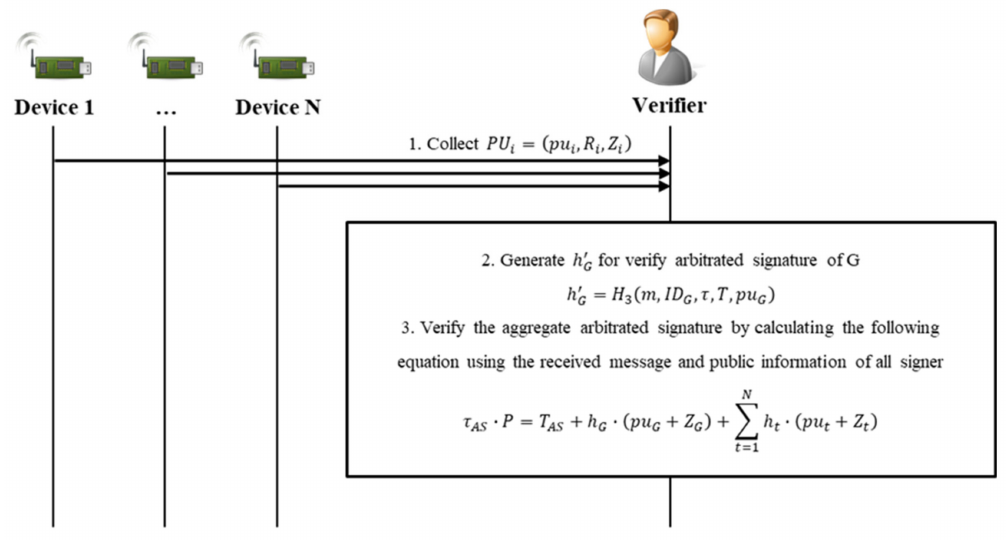
Figure 8. Sequence diagram of aggregated verifying